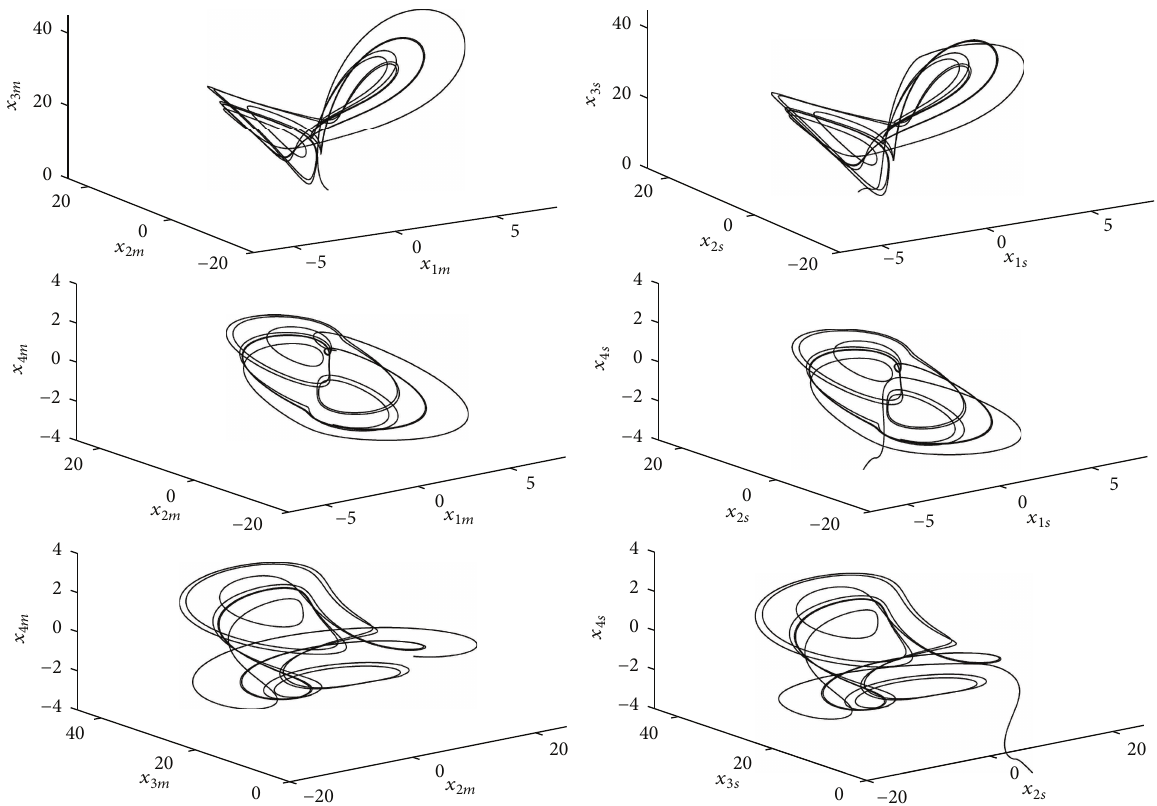
Figure 2: Phase space of the synchronization of the hyperchaotic Lorenz-Stenflo system (12) and its observer (13). The subscripts 𝑚 and 𝑠 represent the variables of master and slave systems (12) and (13), respectively.